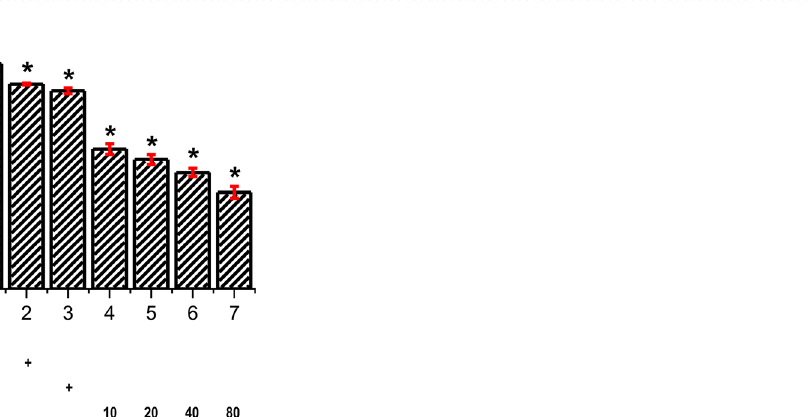
Figure 8. Fluorescence microscopic images of neuroblastoma cells treated by various concentration of FITC labelled MSN and MSN-AmEA.